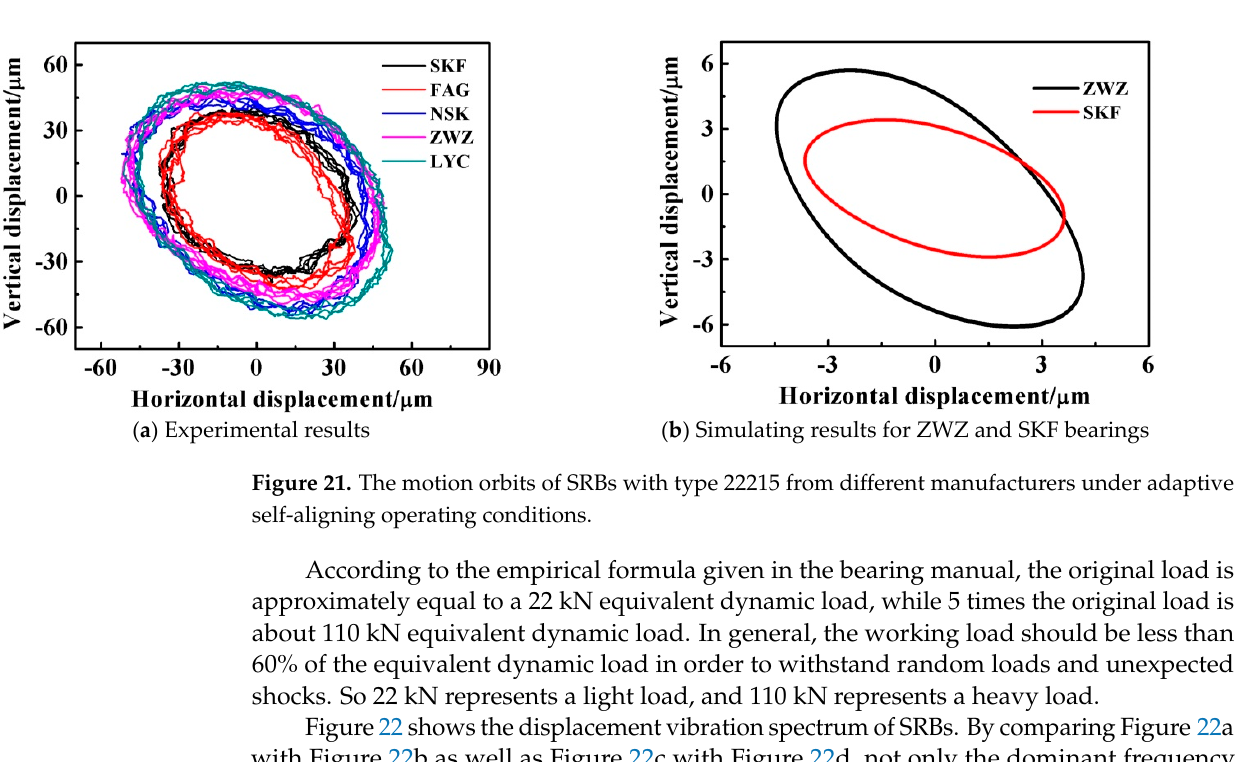
Figure 22. The displacement vibration spectrum of SRBs with type 22215 from different manufac ‐ turers under adaptive self ‐ aligning operating conditions.